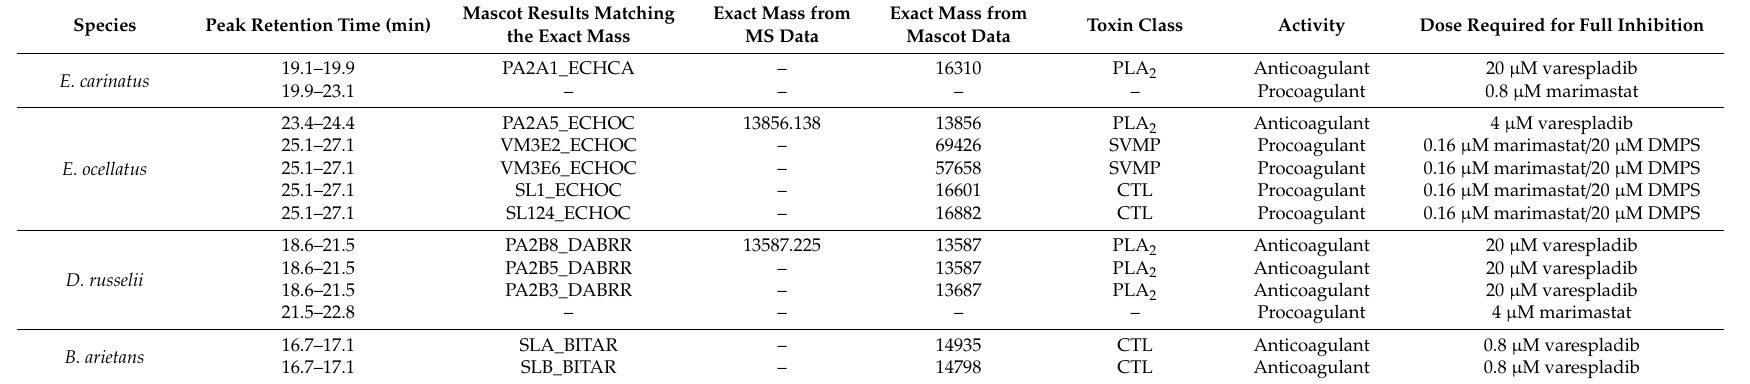
Table 1. Correlated MS and proteomics data for associated coagulopathic venom toxins. (Peak retention times are adapted from Figures 1–4; PLA 2 = phospholipase A 2 ; SVMP = Snake Venom Metalloproteinase; CTL = C-Type